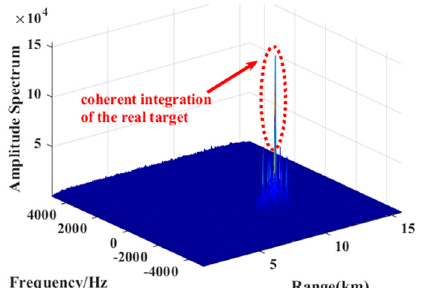
Figure 14. Coherent integration result after compensating based on the improved Keystone algo- rithm.